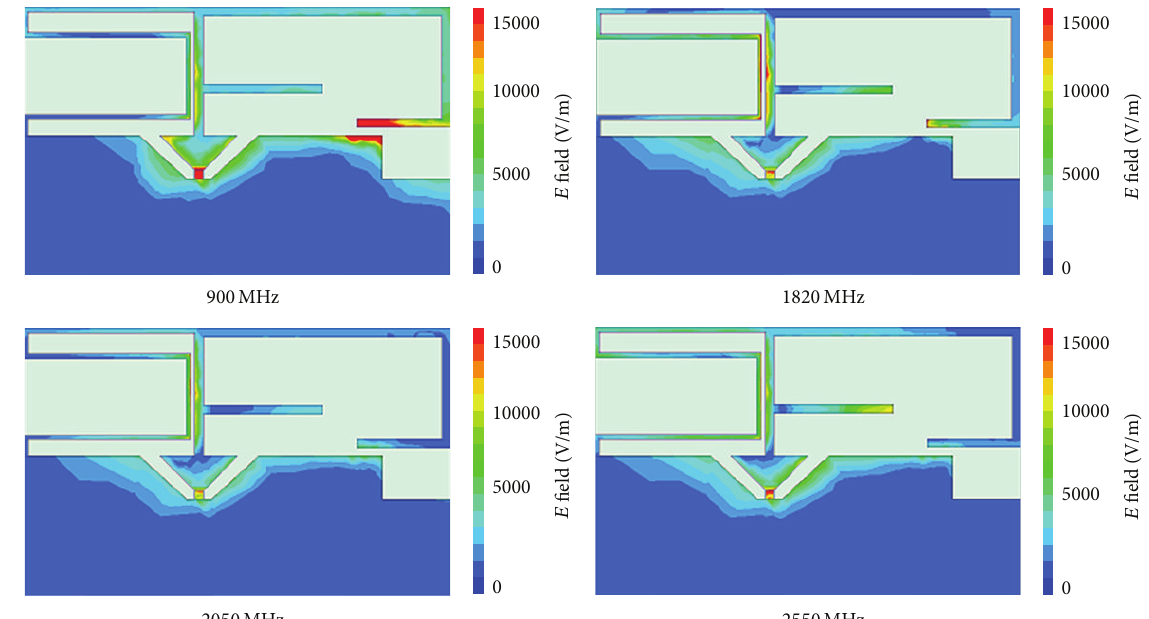
Figure 7: 𝐸 -field distributions at 900, 1820, 2050, and 2550 MHz.